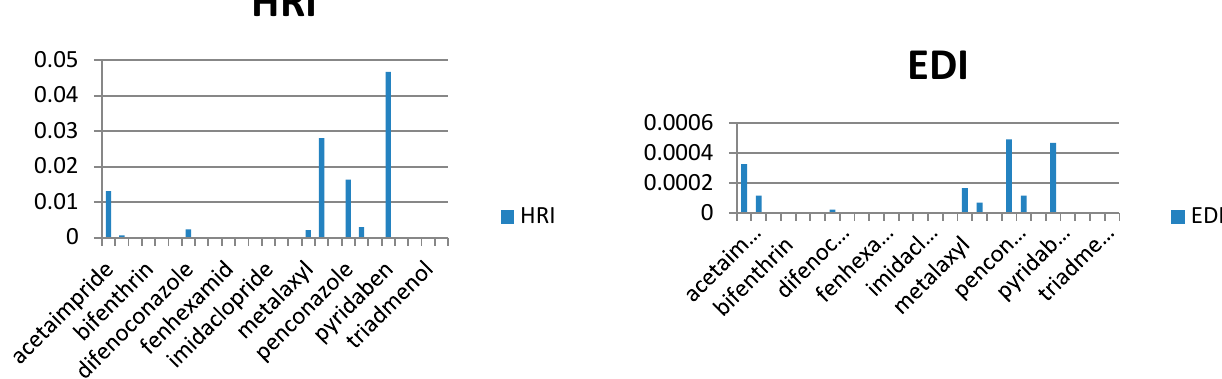
Figure 8. Estimation of EDI and HRI for pesticide residues detected in cucumber.